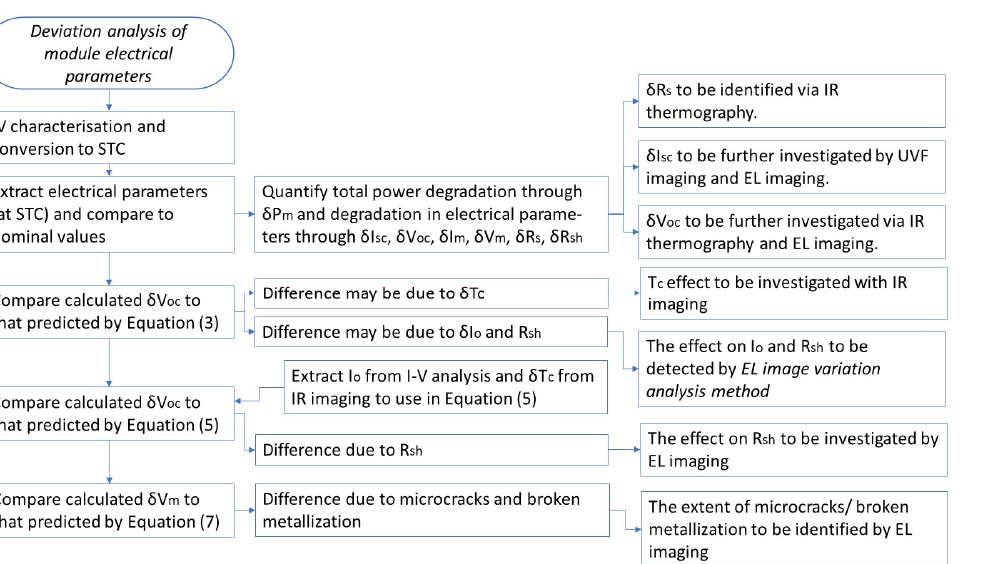
Figure 11. Functional flow-block diagram illustrating the deviation analysis of module-electrical- parameter methodology and synergy with other NDT techniques.